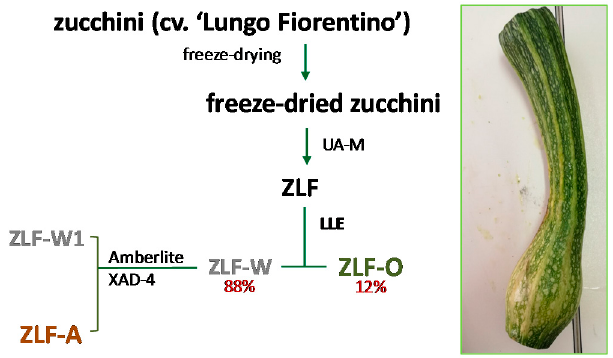
Figure 8. Extraction / fractionation scheme of Cucurbita pepo cv. ‘Lungo Fiorentino’. UA-M = Ultrasound Assisted Maceration; LLE = Liquid-Liquid Extraction.